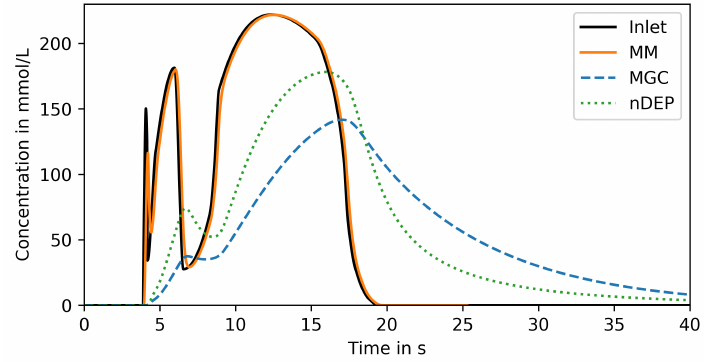
Figure 5. Reproduced signal in trapping region of compared devices for life line